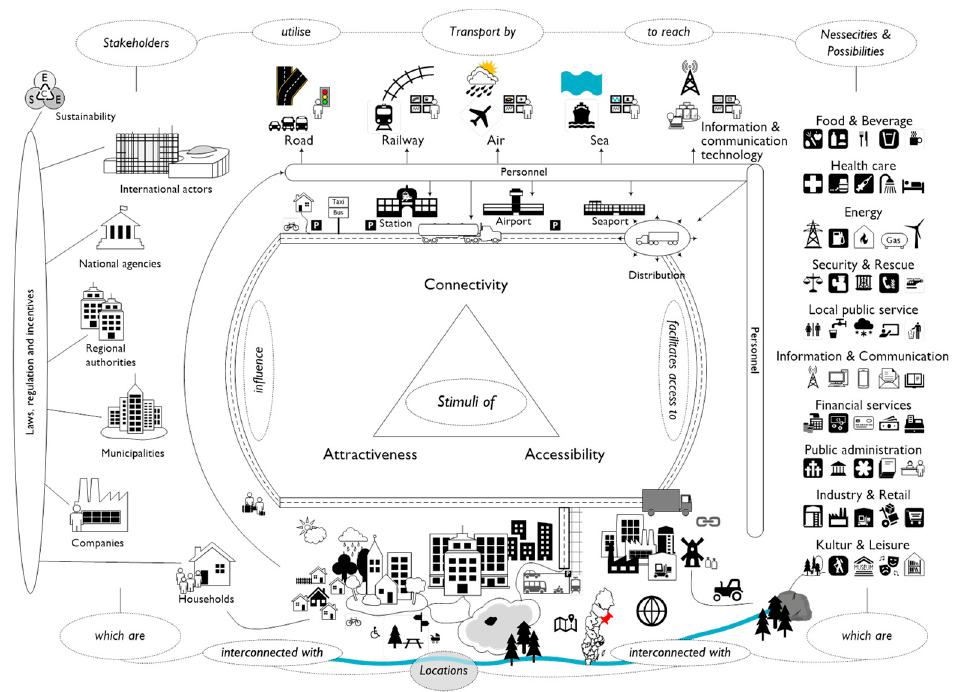
Figure 3. Rich Picture of the transportation system (originated by the author).